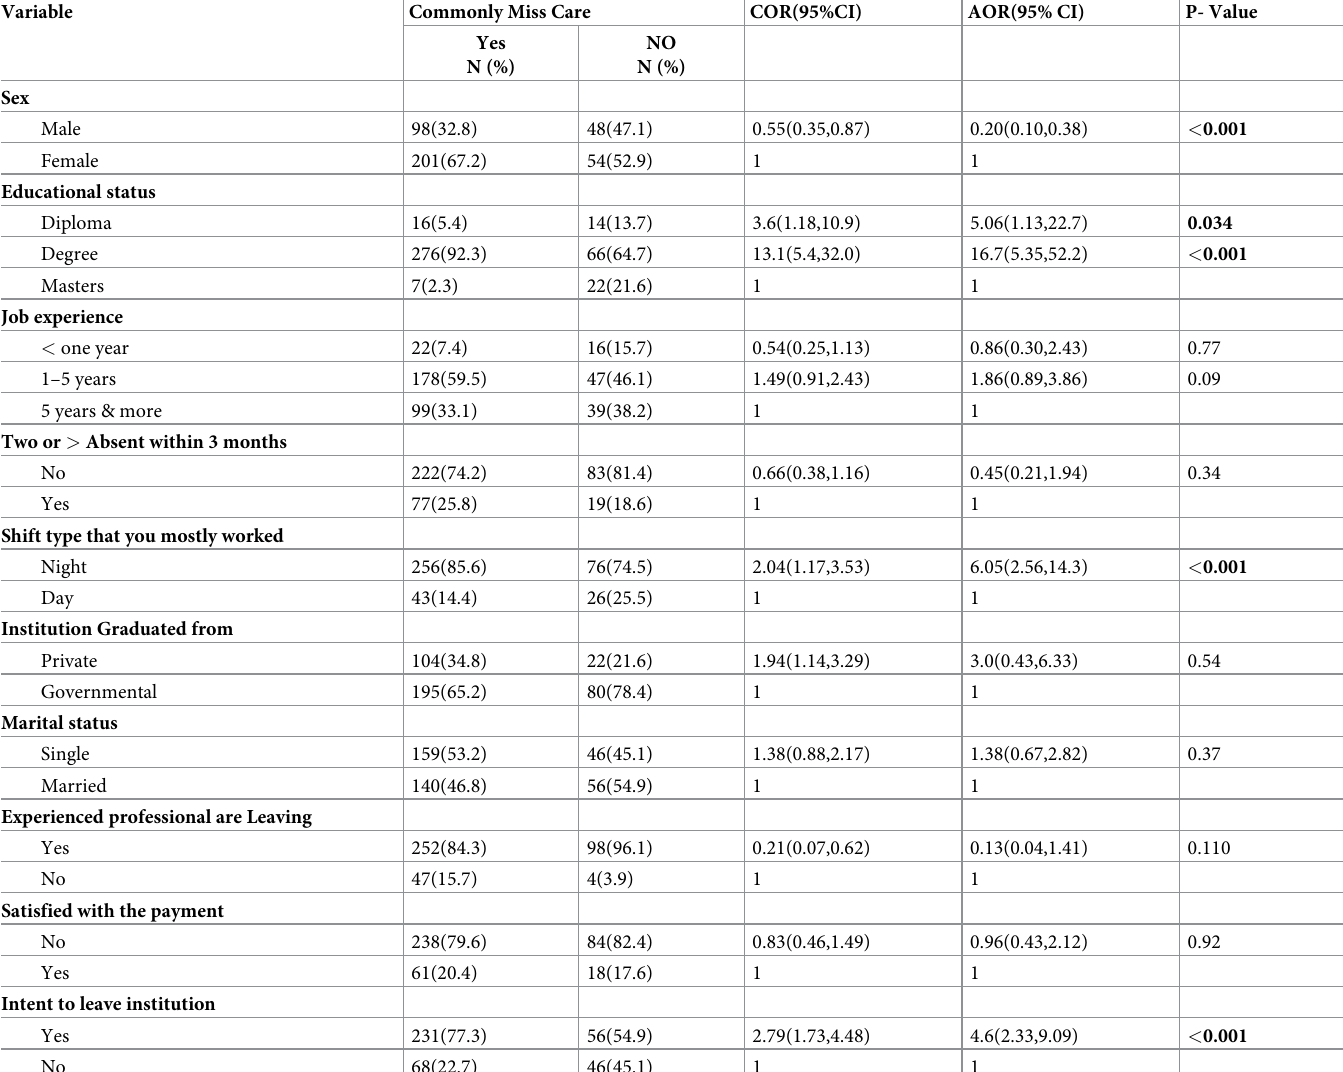
Table 4. Bivariate and multivariate binary logistic results on factors that affect nursing care omission